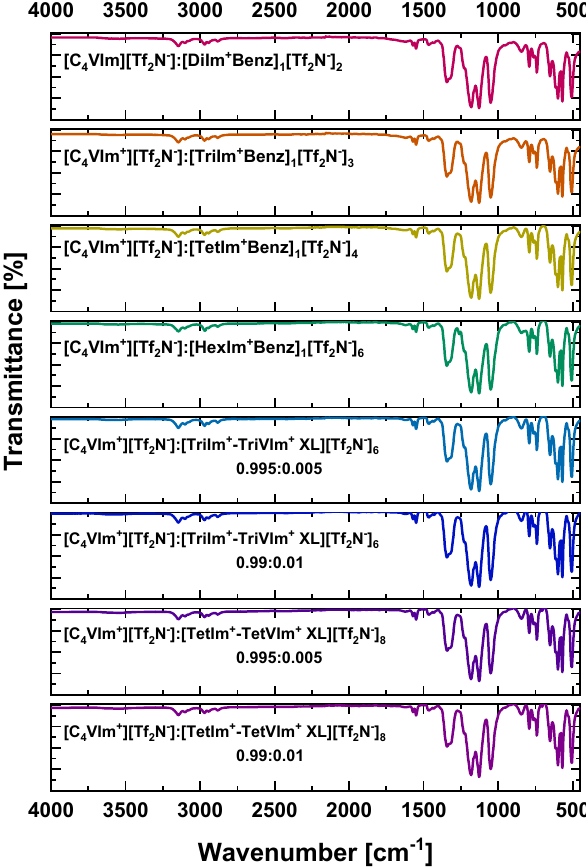
Figure 5. FTIR spectra for all [C 4 vim][Tf 2 N] composite films. Table 1. Composition and characterization data for each PIL